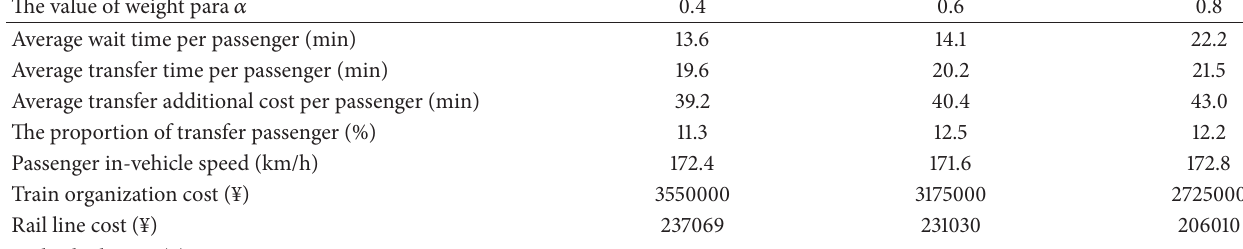
Table 3: Optimization results with different value of 𝛼 .